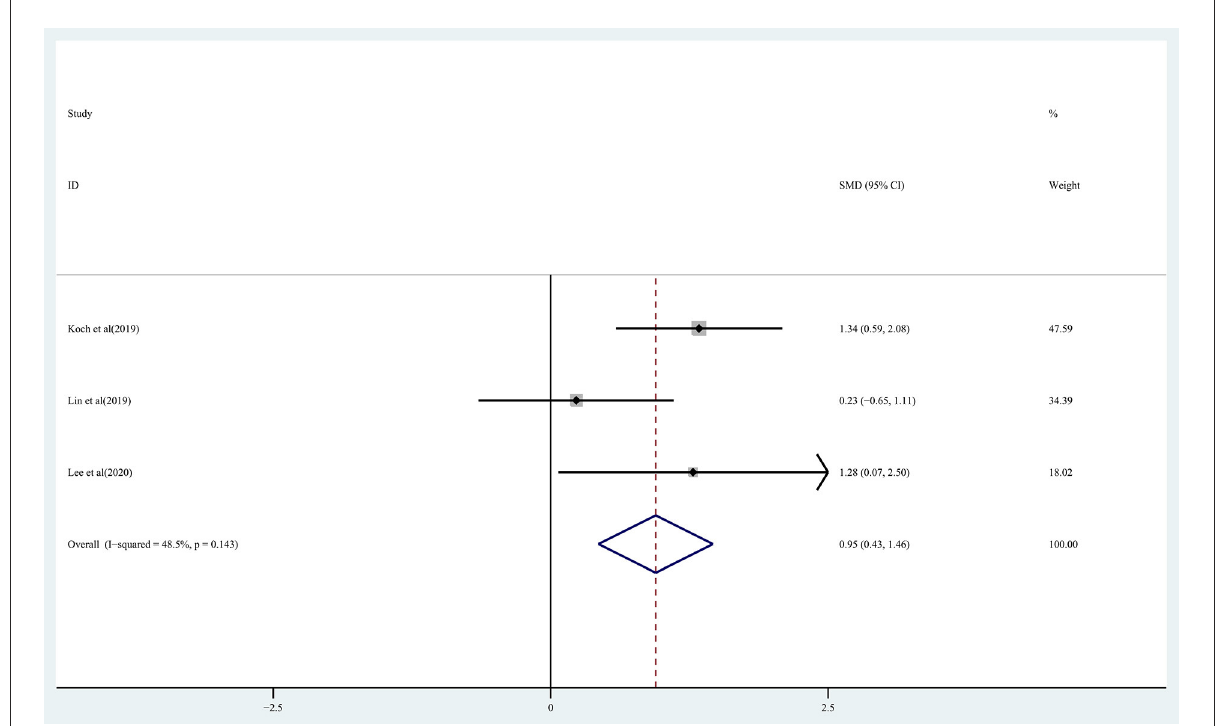
FIGURE7 Forest plot of the effect of rTMS treatment on balance function recovery in chronic stroke